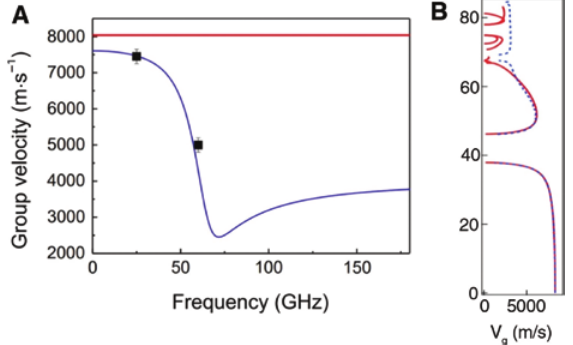
Figure 17: Group velocity in nanowire and nanowire superlattices. (A) Experimentally determined group velocities (black squares) and group velocity calculated for a 75 nm GaN nanowire (blue curve), and group velocity in bulk GaN (red curve). (B) Group velocity in an AlN/ GaN superlattice. Reproduced from [36]. Copyright (2018) The Japan Society of Applied Physics.